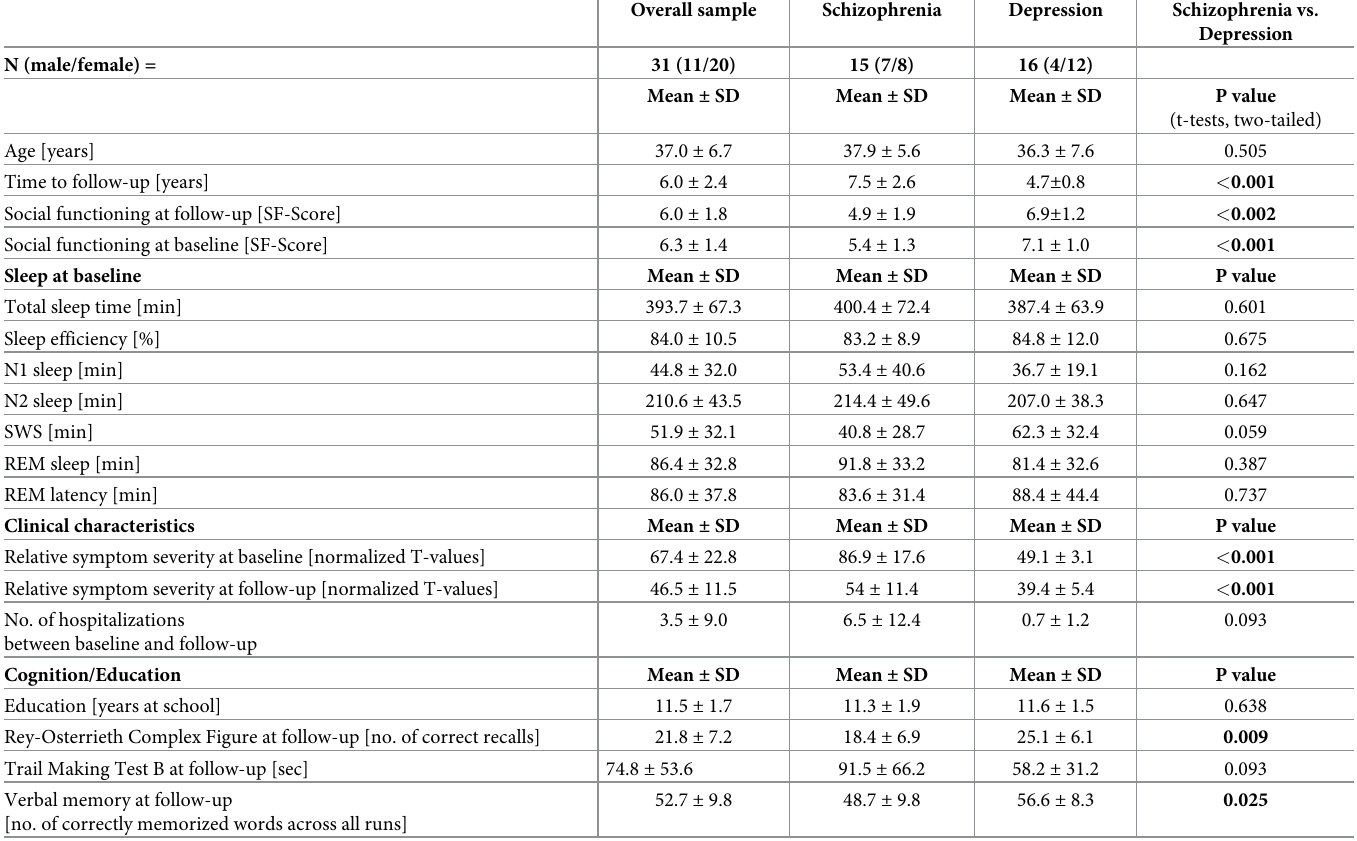
Table 1. Sample characteristics regarding demographic and epidemiological measures, sleep parameters, disease severity, and